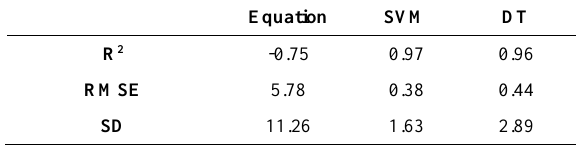
Table 4. The calculated statistical parameters for the empirical equation as well as DT and SVM models